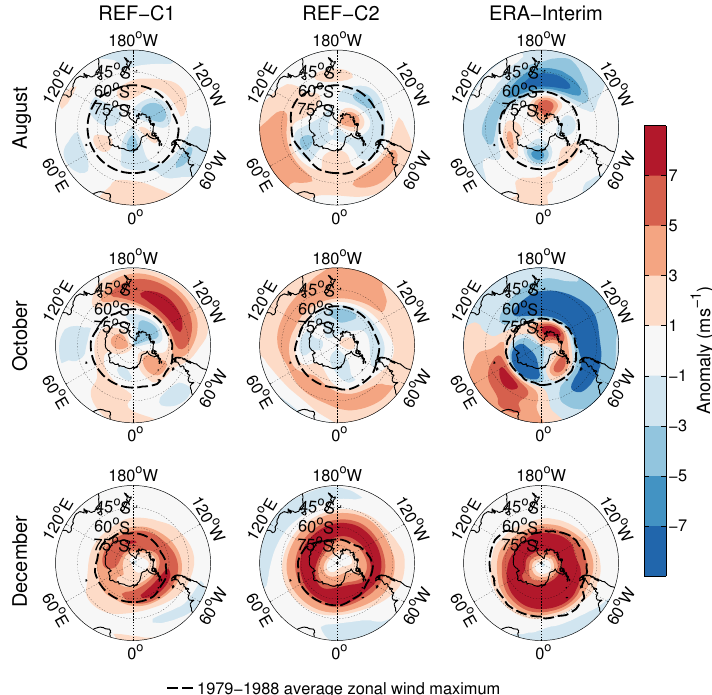
Figure 8. 2001–2010 minus 1979–1988 50hPa zonal wind anomaly maps for REF-C1 and REF-C2 simulations compared to ERA-Interim